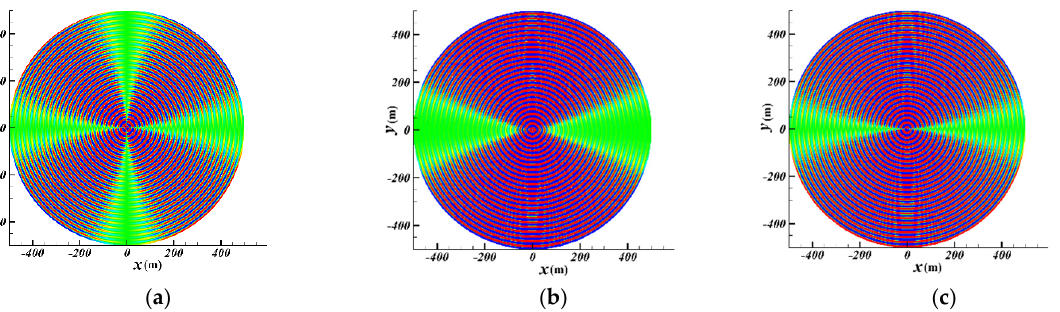
Figure 5. The spatial distribution of the disturbance variables. ( a ) Flow pulsating velocity. ( b ) Normal pulsating velocity. ( c ) Pulsating pressure.